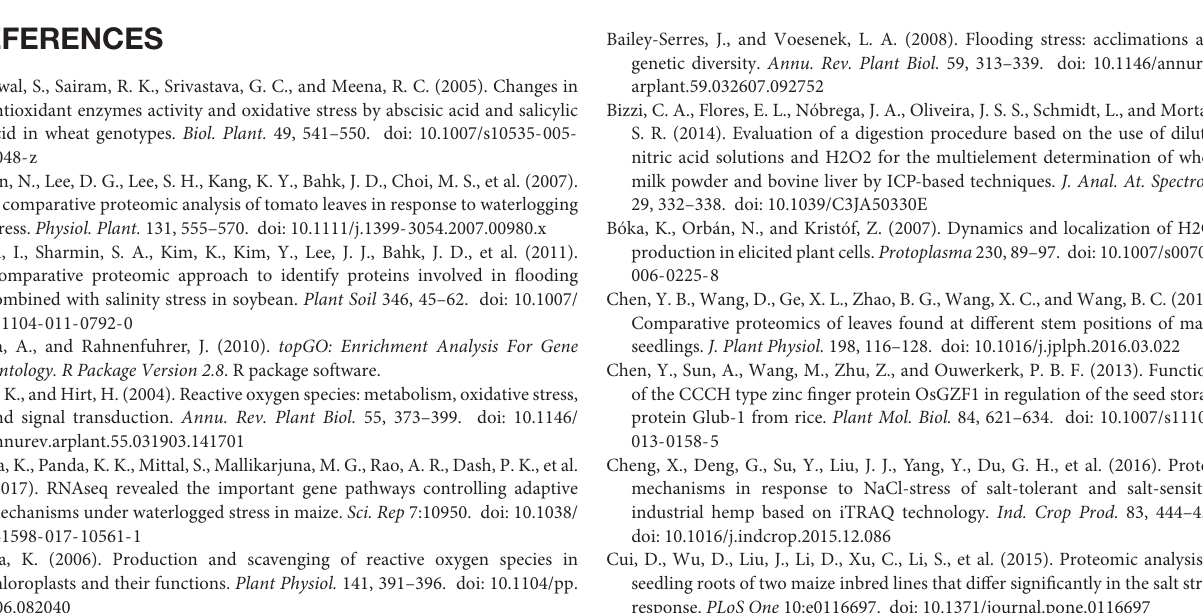
Supplementary Figure 1 | Pearson’s correlations of quantitation among treatments. Supplementary Figure 2 | GO analysis of DEPs in the T0d vs. T10d comparison group. Supplementary Figure 3 | GO analysis of DEPs in the T10d vs. T20d comparison group. Supplementary Figure 4 | GO analysis of DEPs in the T0d vs. T20d comparison group. Supplementary Table 1 | Primer sequences of DEP-encoding genes used for qRT-PCR. Supplementary Spreadsheet 1 | Differentially expressed proteins identified in grapevine rootstock leaves. Supplementary Spreadsheet 2 | Details of all the differentially expressed proteins. Supplementary Spreadsheet 3 | Details of the GO enrichment analysis of DEPs among the various comparison groups. Supplementary Spreadsheet 4 | Statistics of GO annotations of DEPs among the various comparison groups. Supplementary Spreadsheet 5 | Details of KEGG pathway enrichment analysis of DEPs among the various comparison groups. Supplementary Txt 1 | PPI analysis of the connectivity degree in the T0d vs. T10d comparison group. Supplementary Txt 2 | PPI analysis of the connectivity degree in the T10d vs. T20d comparison group. Supplementary Txt 3 | PPI analysis of the connectivity degree in the T0d vs. T20d comparison